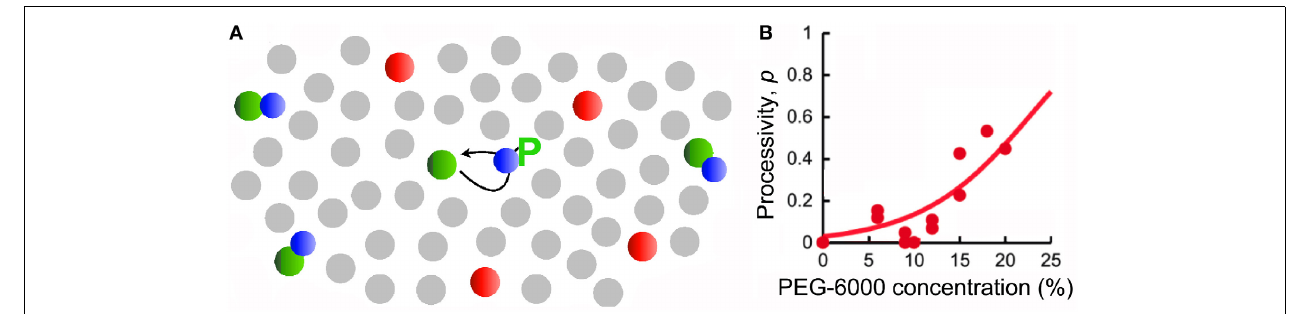
FIGURE 6 | Stimulation by crowding of the processivity of a step in a signaling pathway. (A) In the MAPK pathway MEK (Mitogen/Extracellular signal-regulated Kinase) (green) phosphorylates ERK (Extracellular signal-RegulatedKinase)(blue)attwopositions,ontyrosineandthreonine.The system also contains phosphatases (red). In the presence of crowders (gray) thereactantsdiffusemoreslowly,andthereforetheprobabilityofrebindingand